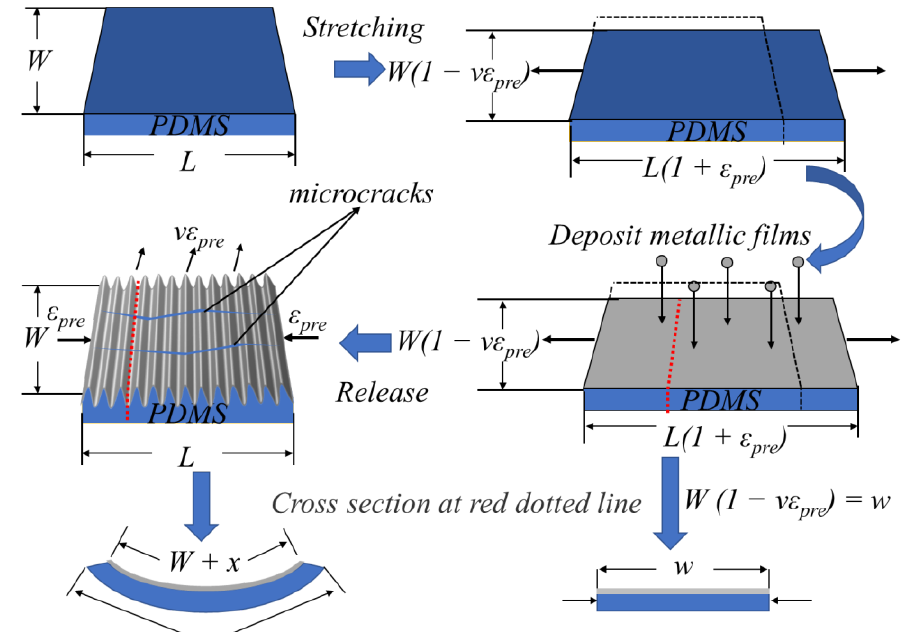
Figure 1. Schematic diagram of microcrack formation in wrinkled metallic thin films prepared by the prestrain method; the transverse strain leads to the formation of microcracks after releasing the prestrain.